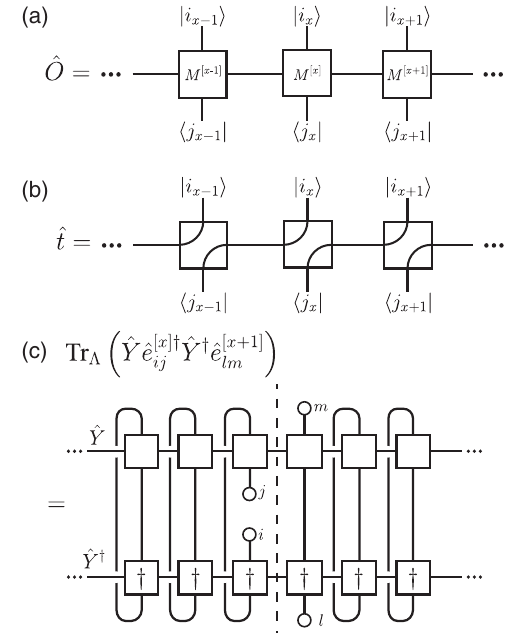
FIG. 4. MPU representations. (a) The matrix-product repre- ˆ O , Eq. (26), has a simple diagrammatic sentation of an operator representation, where each tensor is represented by a box with legs corresponding to the various linear spaces. Connected legs represent contraction. (b) The tensor T ½ x (cid:3) defining the translation operator ˆ t can be pictured as a particular connection of the physical and virtual legs, which leads to a “ pipeline ” shoveling quantum information uniformly to the right. (c) A similar analogy applies to the diagrammatic representation of information across the cut (dashed line) under the action of ˆ Y the MPU